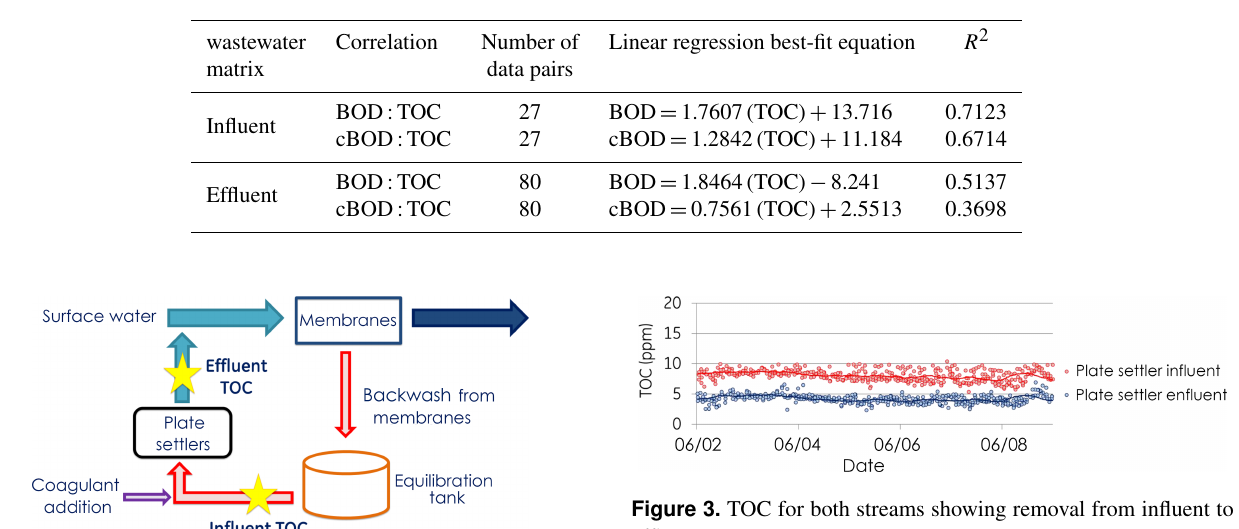
Table 1. Summary of the City of Boulder’s long-term correlation between BOD and TOC and between cBOD and TOC for both plant influent and final effluent wastewater matrices.